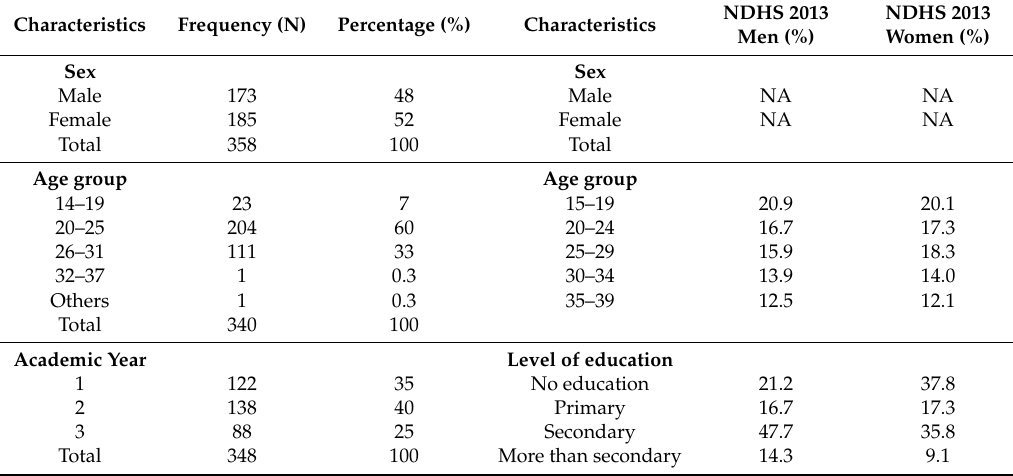
Table 1. Characteristics of the undergraduate students.